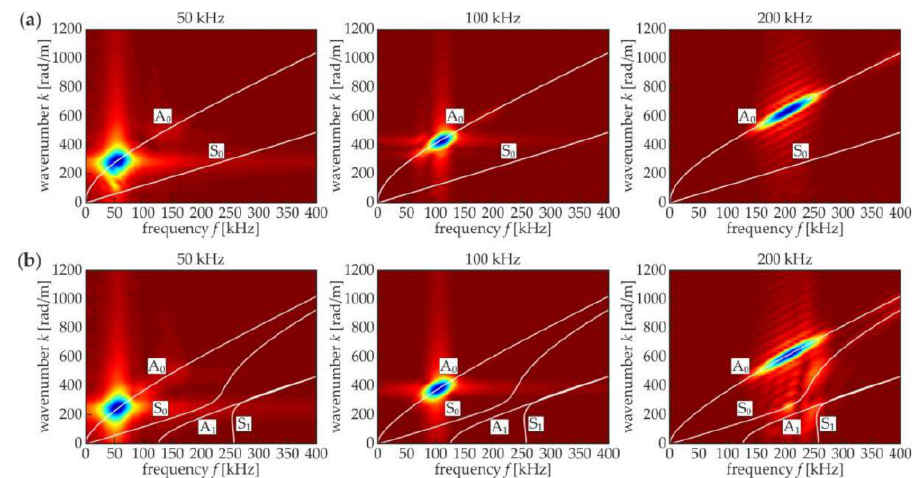
Figure 6. Experimental and theoretical dispersion curves obtained for different excitation frequencies of 50 kHz, 100 kHz, and 200 kHz: ( a ) steel 3 mm plate ( E = 195.2 GPa, v = 0.3, ρ = 7741.7 kg/m 3 );